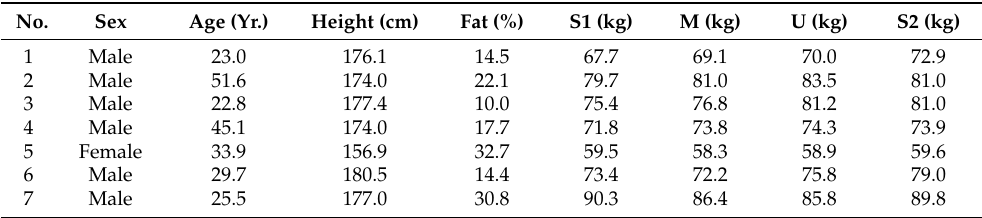
Figure 1. The participant recruitment and selection process. Table 1. The characteristics of subjects.